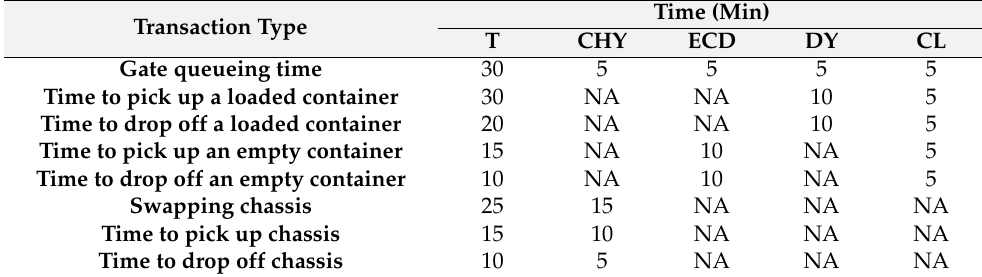
Table 4. Transaction Times at T, CHY, ECD, DY, and